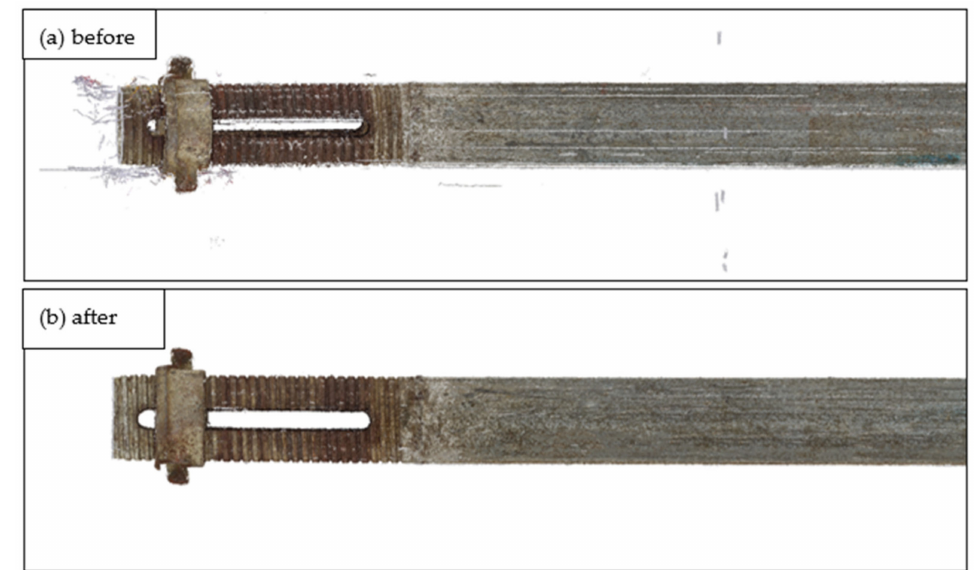
Figure 18. Noise removal. ( a ) Before, ( b ) after.